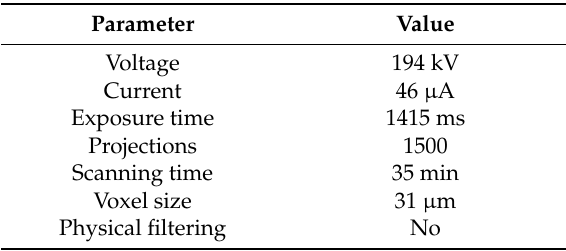
Table 2. Computed tomography (CT)-scanning parameters optimized for the standard polyethylene (STD_PE) acetabular cups.